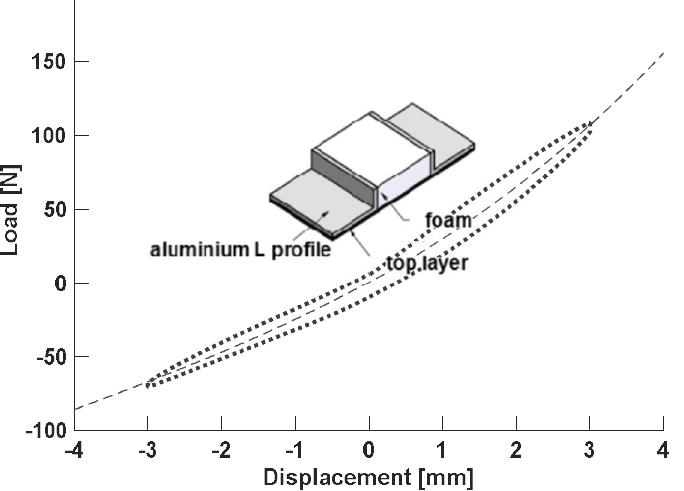
Figure 13. Load‒displacement hysteresis loop from ramped cyclic test at crosshead speed ±0.3 mm/s.